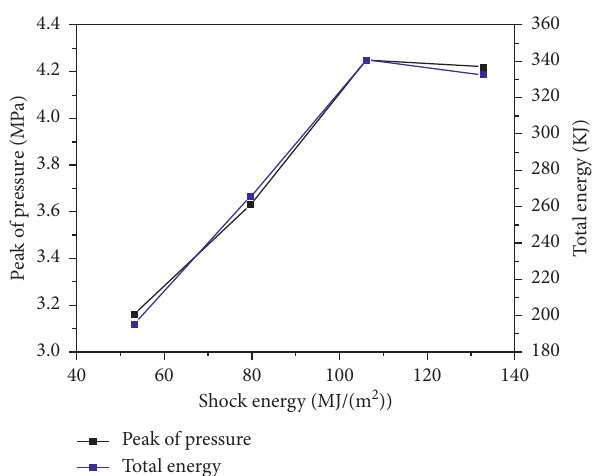
Figure 19: Comparison of the peak pressure and energy release of the Al/PTFE/W energetic jets for different target thicknesses.